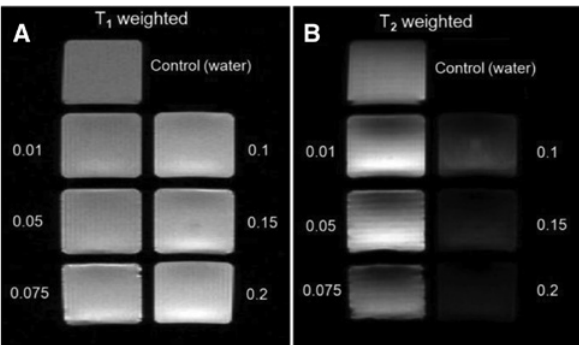
Figure 16: MR images of T1-weighted (A) and T2-weighted (B) NaGd(MoO ) NP suspensions at concentrations ranging from 4 2 0.01 mm (top left) to 0.2 mm (bottom right). Taken from [89]. Published by The Royal Society of